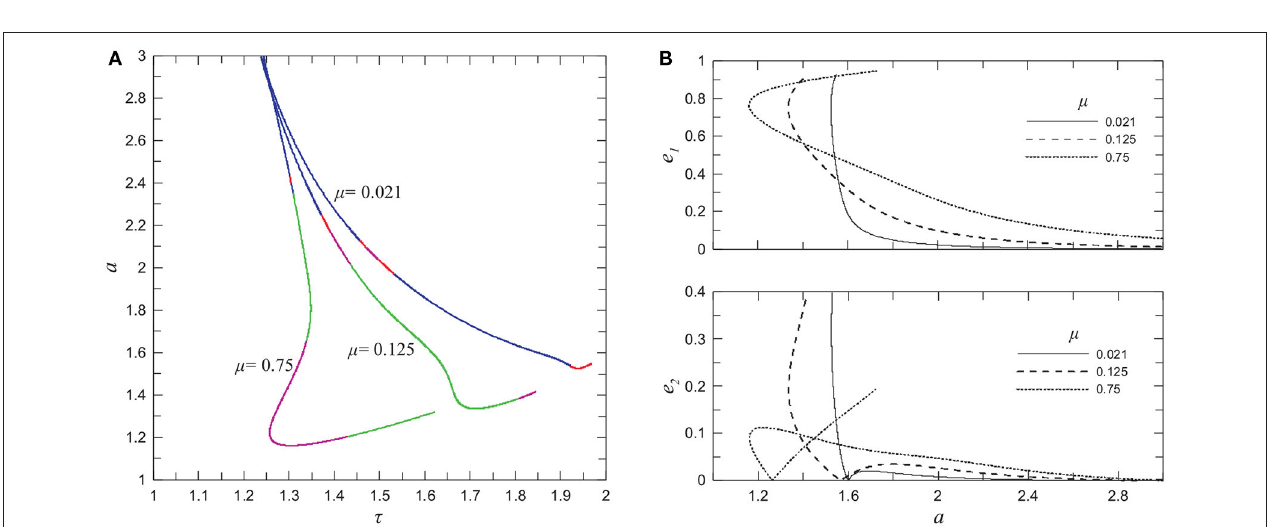
FIGURE 3 | (A) The variation of the distance parameter a and the normalized period τ along the family S ( µ ; a 0 ) (B) The variation of the eccentricity of the inner binary ( e 1 ) and the outer body ( e 2 ) along the same family.